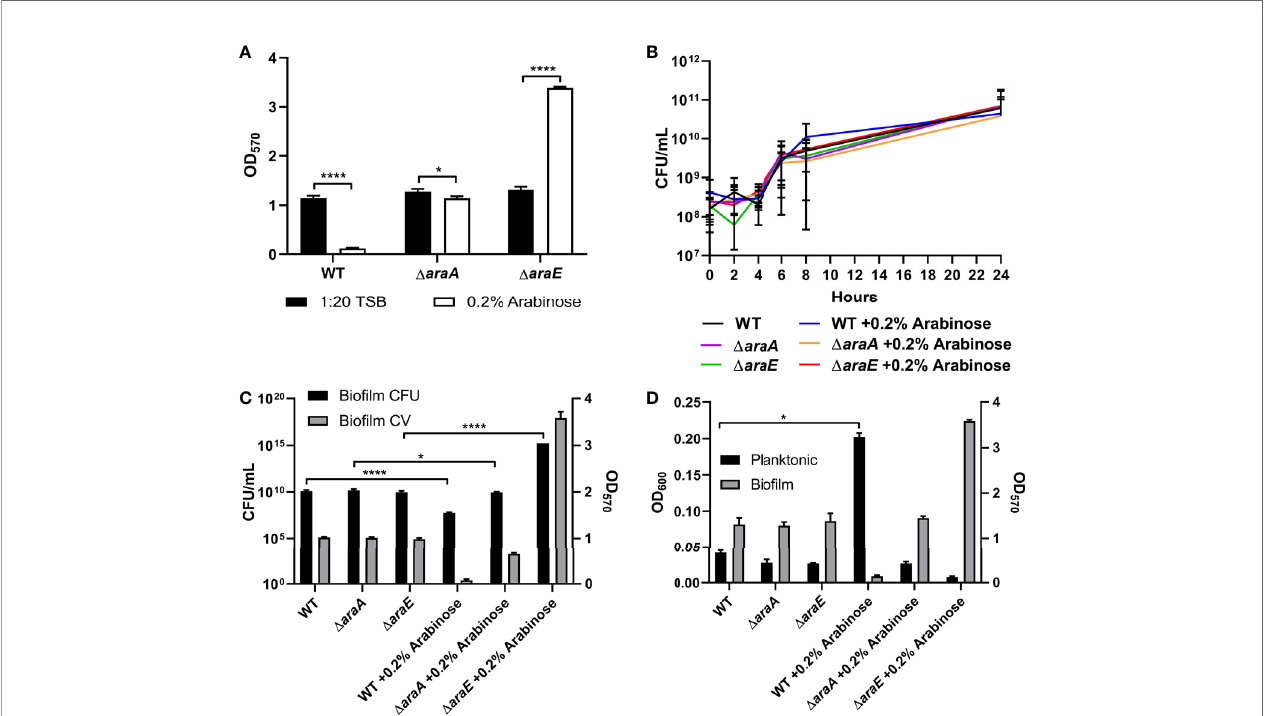
FIGURE 1 | L-arabinose affects bio fi lm formation but not growth. (A) WT 14028, D araA and D araE strains were grown in 96-well plates in 100 µL 1:20 TSB (black bars) or 1:20 TSB with 0.2% L-arabinose (white bars). After 24 hours, planktonic cells were removed, then bio fi lms were washed, heat fi xed, and stained with crystal violet (CV) for relative bio fi lm measurement as determined at OD 570 . (B) WT 14028, D araA and D araE strains were grown in 5 mL tubes in 4 mL 1:20 TSB or 1:20 TSB with 0.2% L-arabinose. Aliquots were removed at designated time points and plated for colony forming units (CFU). (C) After 24 hours, bio fi lms were removed for CFU enumeration compared to CV staining (OD 570 ). (D) After 24 hours, planktonic cell density was determined at OD 600 compared to bio fi lm CV staining (OD 570 ). Data are mean ± SD, statistical analyses were done using a two-way ANOVA with Dunnett ’ s multiple comparisons test * P < 0.05; **** P <